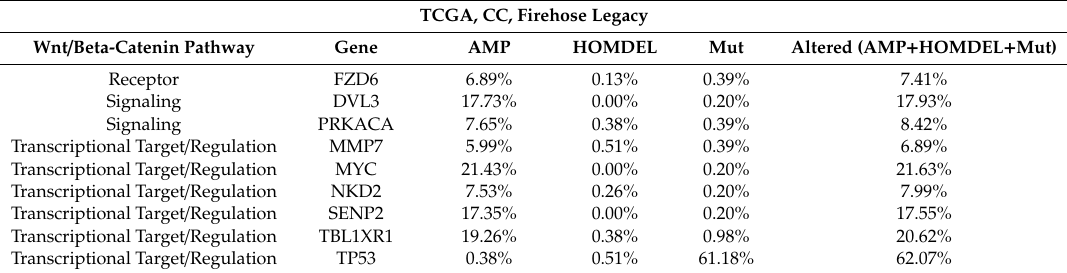
Table 3. Canonical and non-canonical Wnt / β -catenin signaling pathway alterations in Cervical Squamous Cell Carcinoma and Endocervical Adenocarcinoma. The Cancer Genome Atlas (TCGA), Firehose Legacy. Wnt / β -catenin KEGG Pathway (150 genes). AMP = amplification, HOMDEL = homozygous deletion, Mut =